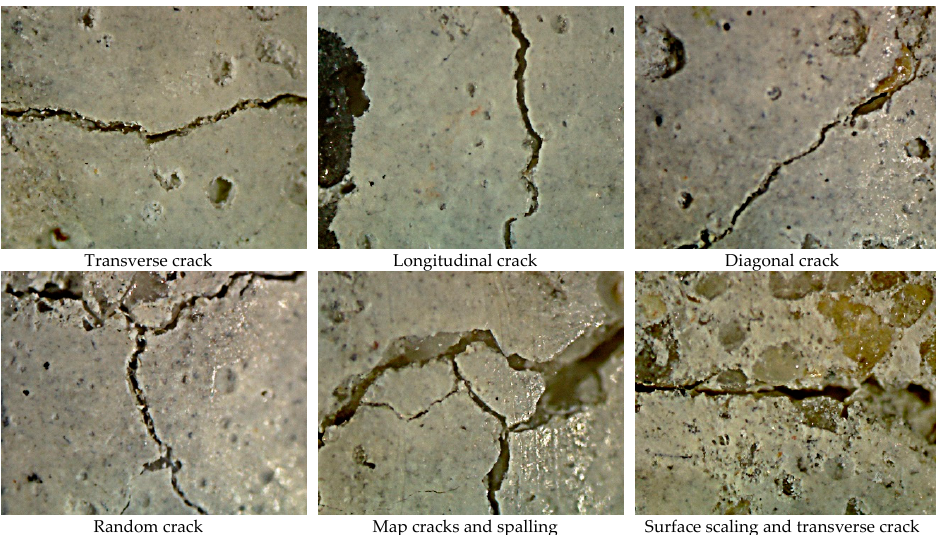
Figure 10. A representative view of cracks formed on the surface of 12% OPC mortars observed under a light microscope after 84 days of immersion in Na 2 SO 4 solution at 25 °C.